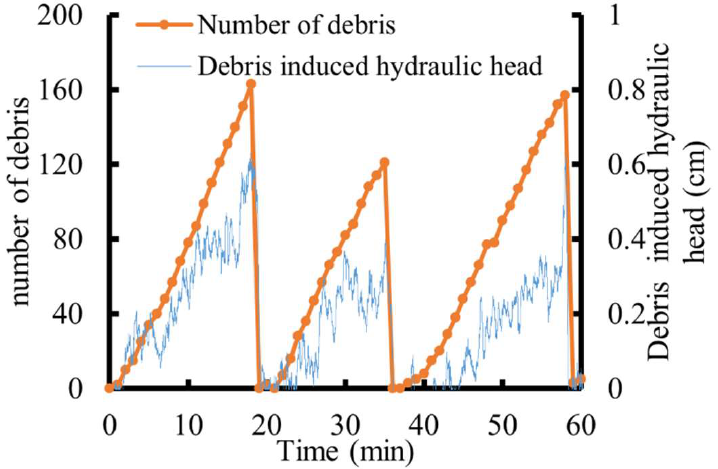
Figure 8. Time-history of the hydraulic head and the number of debris pieces in front of the pier test 2.